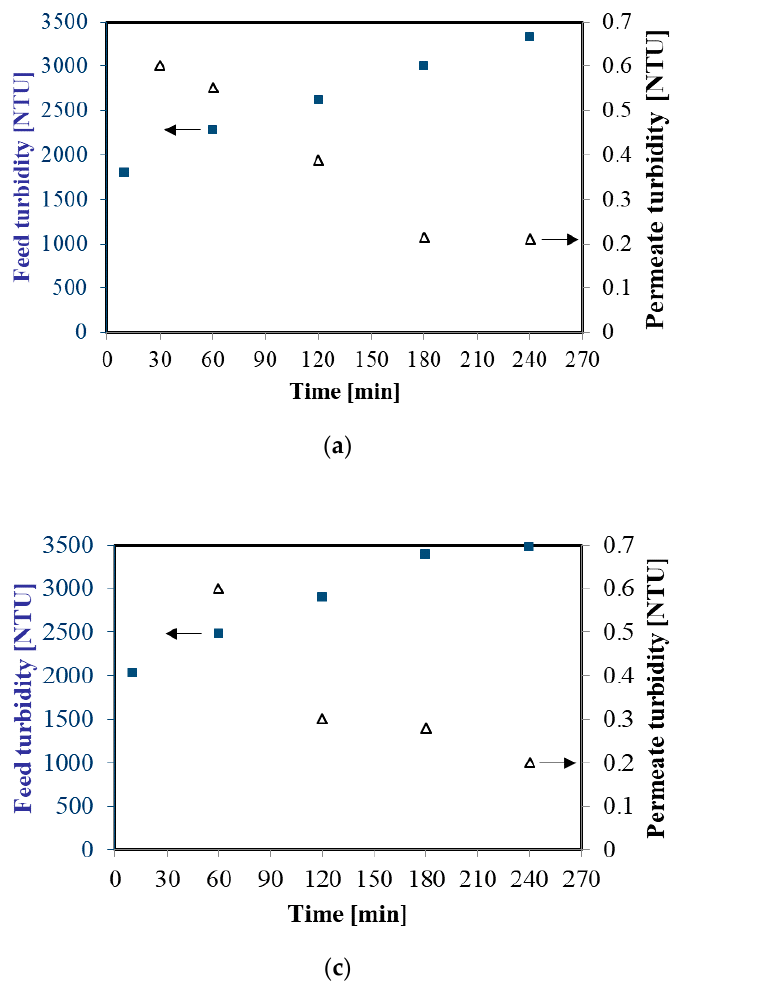
Figure 2. Changes of feed and permeate turbidity during cross-flow MF process, Transmembrane Pressures (TMP) = 0.08 MPa. ( a ) 250 dm 3 /h; ( b ) 500 dm 3 /h; ( c ) 750 dm 3 /h; and ( d ) 1000 dm 3 /h.